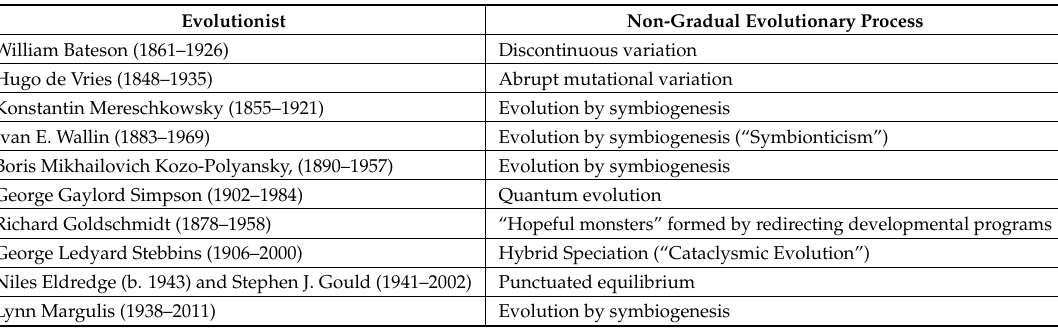
Table 1. Key Scientists Advocating non-Gradualist Evolution in the 19th and 20th